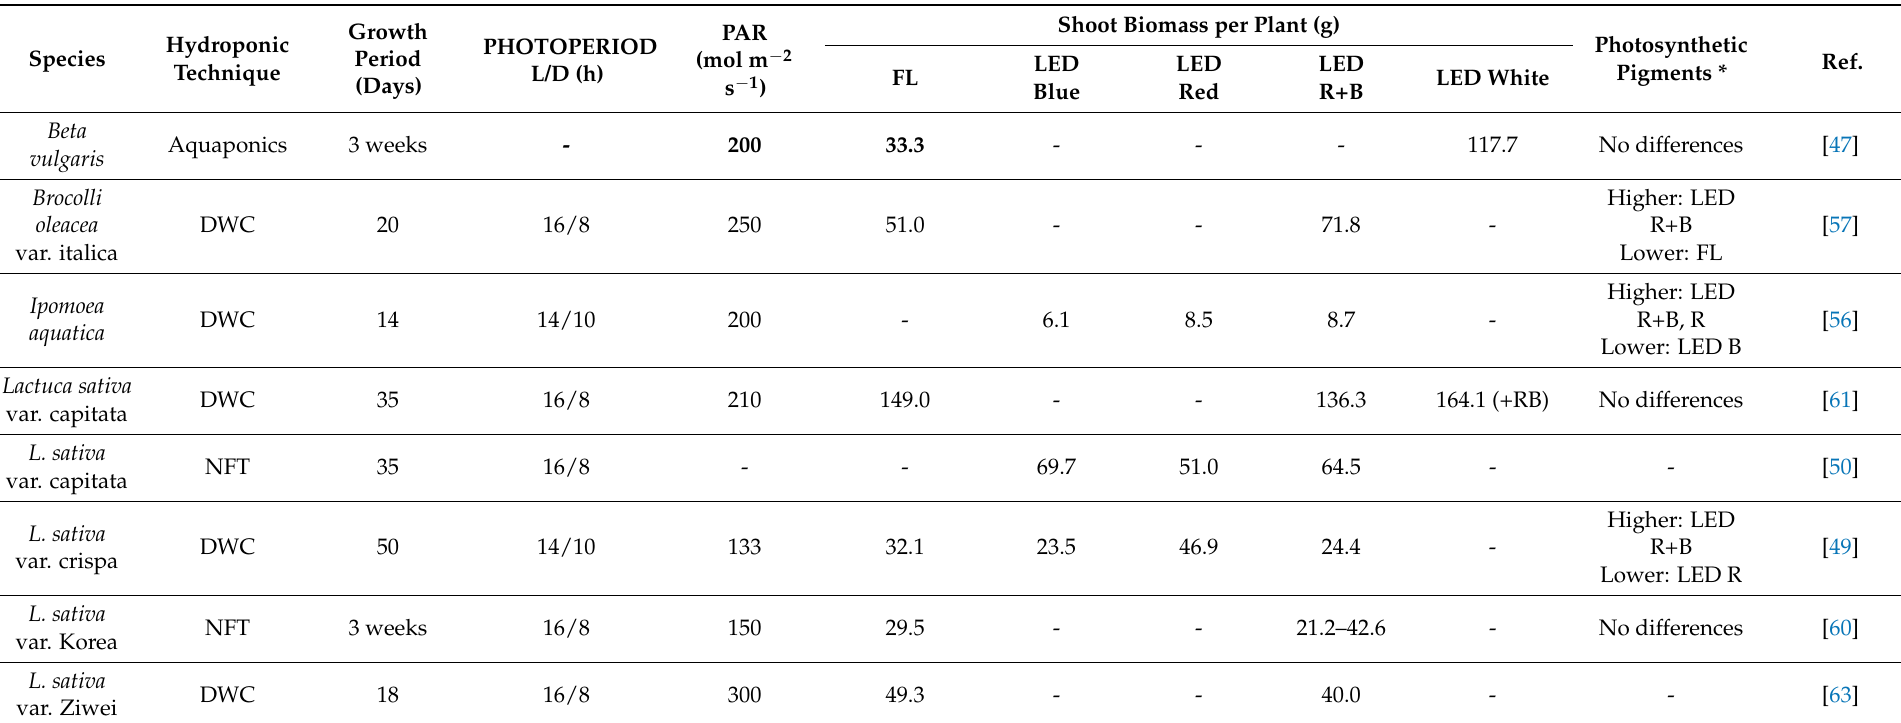
Table 4. Hydroponic-based studies of vegetative growth performance and photosynthetic pigment accumulation of leafy greens under different LED spectra and fluorescent lighting. DWC—-deep water culture; NFT—-nutrient-film technique; FL—-fluorescent lighting.